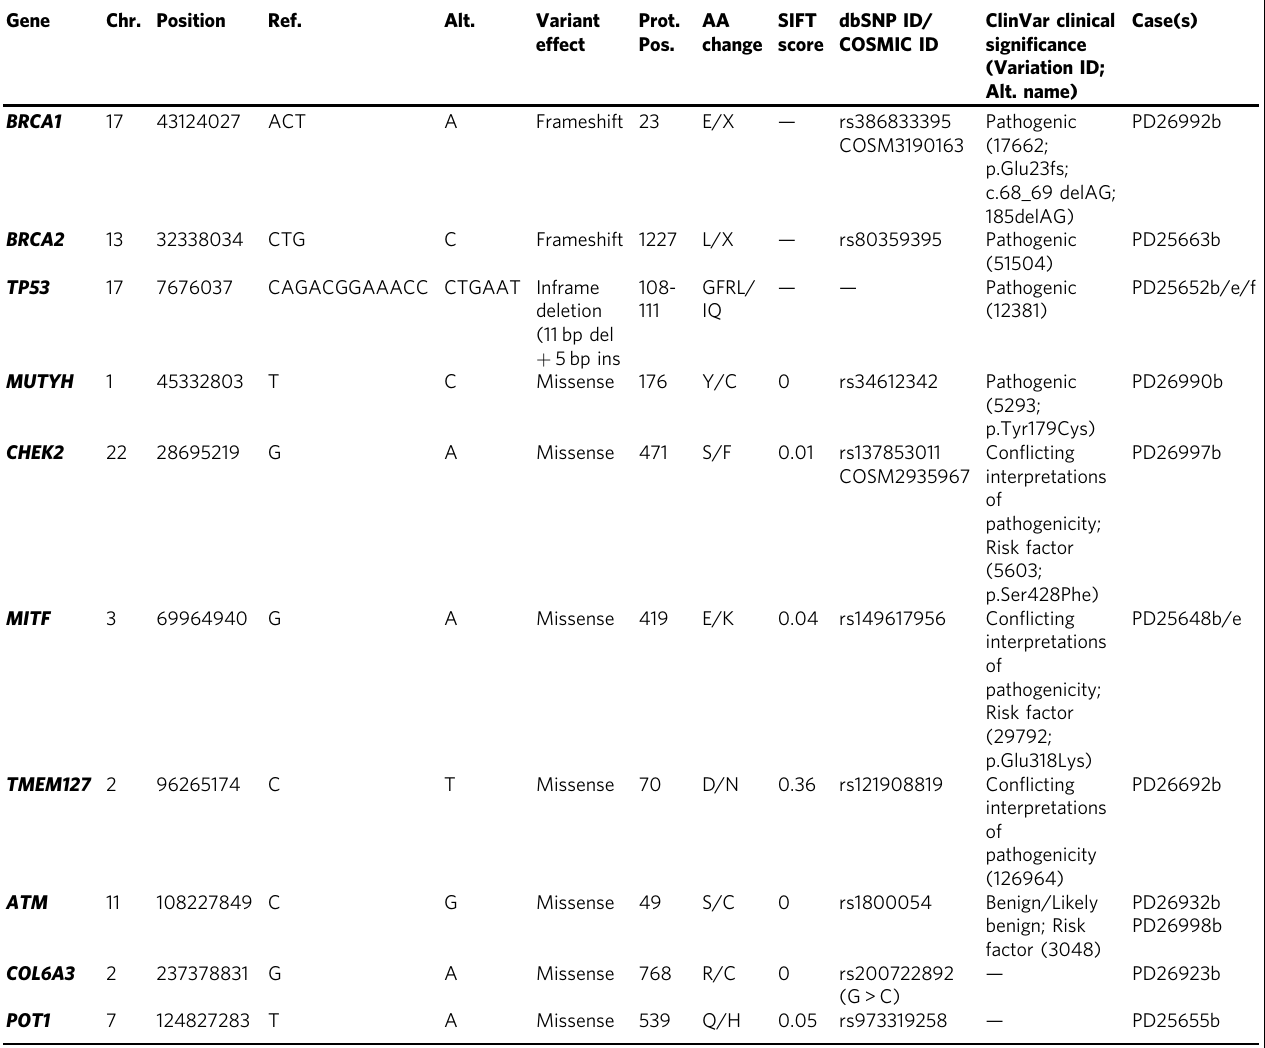
Table 2 Selected germline variants in human mucosal melanomas Gene Chr.